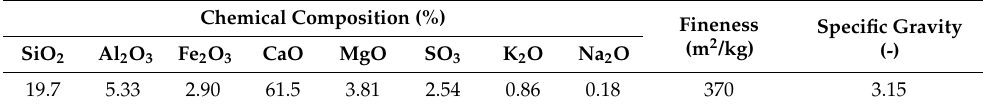
Table 1. Chemical composition and physical properties of cement.